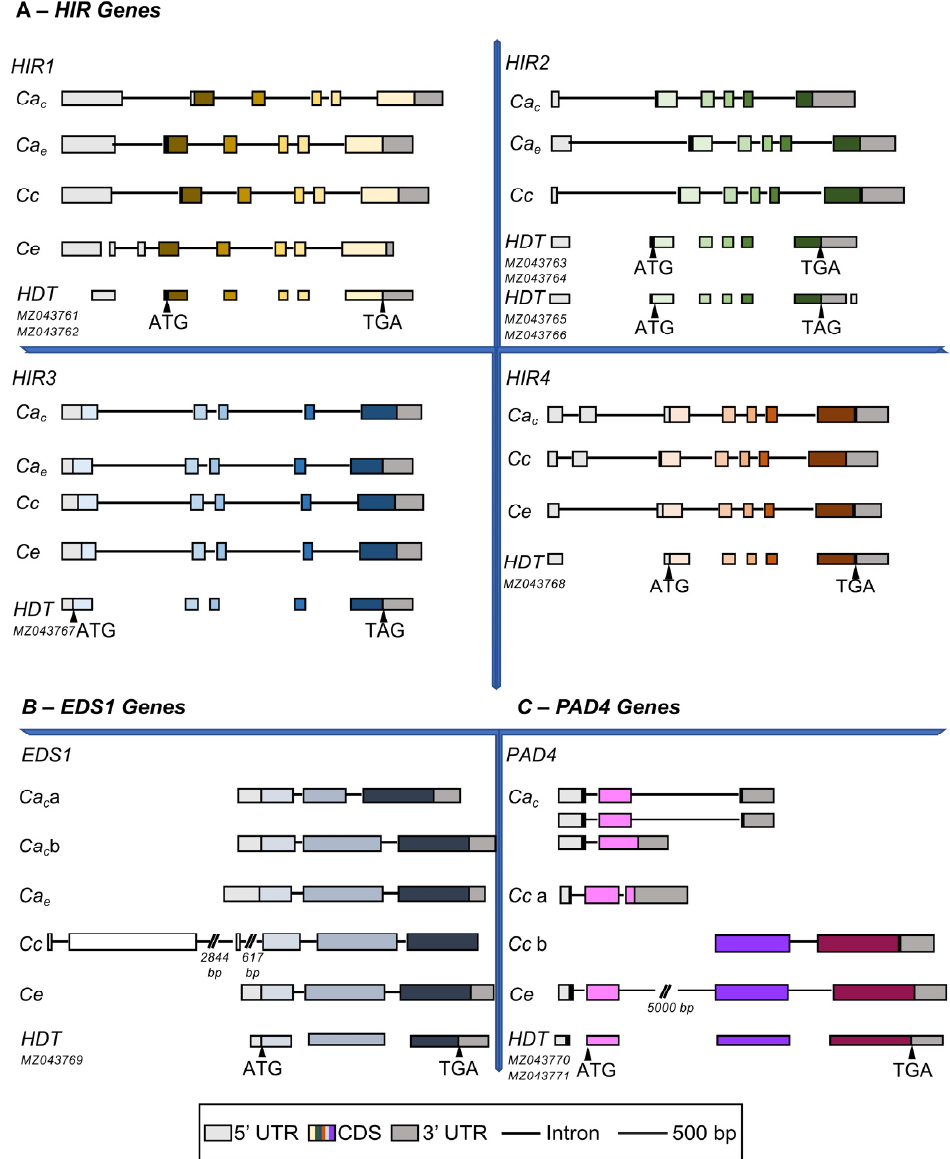
Figure 4. Schematic diagram of the exon–intron structure of HIR ( A ), EDS1 ( B ) and PAD4 ( C ) genes from Coffea arabica , C. canephora and C. eugenioides . Also included is the representation of the predicted exons from transcripts of the same genes from HDT. Exons are represented by boxes, introns by black lines and untranslated region (UTR) by gray boxes. HIR1 genes showed that the nucleotide substitutions between C. arabica and HDT occurred mainly in the UnTranslated Regions (UTRs) (Figure S1.1). The aa di ff erences in the HIR1 gene are between homoeologous chromosomes in the C. arabica genome. The alignment of HIR2 genes shows at the 3 ′ end, around the predicted stop codon, a nucleotide inclusion of 23 bp in Ca c HIR2 , which incorporated a premature stop codon (TAG). Ca e HIR2 does not have this sequence and the stop codon (TGA). Curiously this major di ff erence between the two homoeologous genes does not change the protein size but alters the last three aa (SSS instead of EHL, Figure S1.2). Of the four HDTHIR2